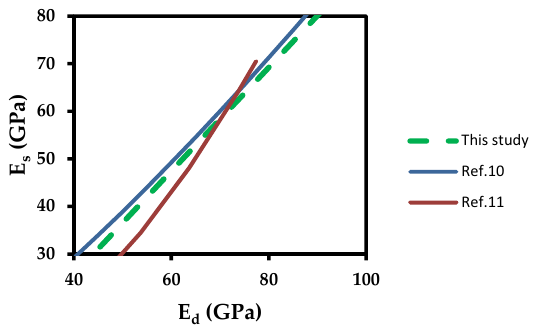
Figure 7. Comparison of previously published non-linear relationship with the developed equation in this study.